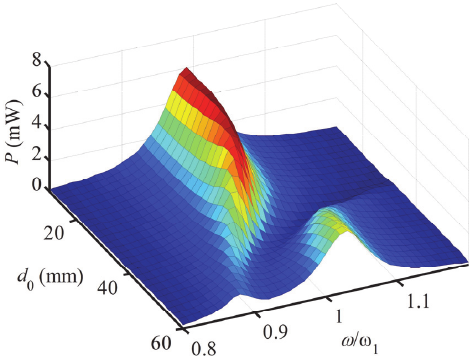
Figure 4. Output power versus excitation frequency for different d 0 .